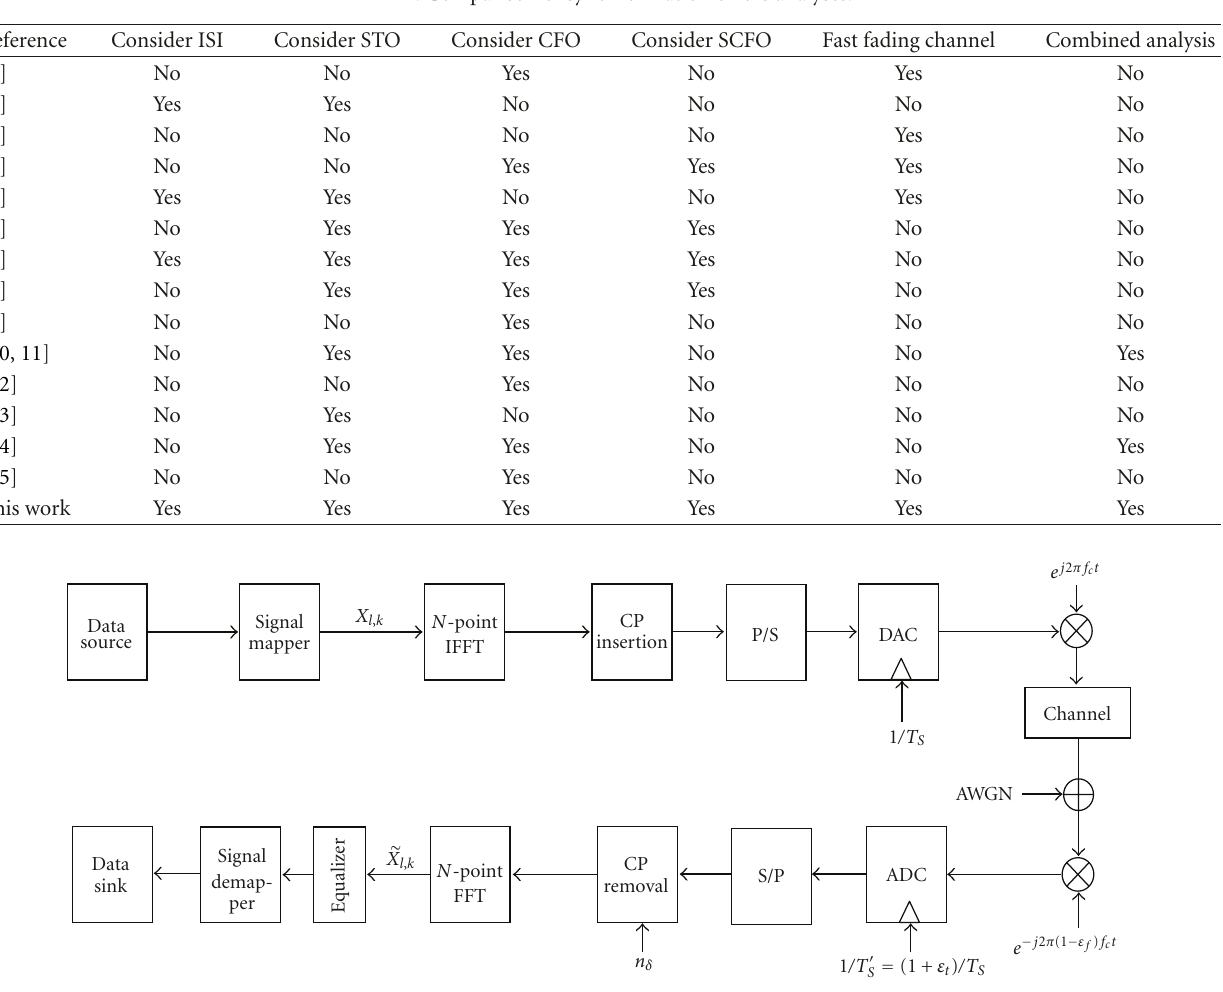
Figure 1: A simplified OFDM system